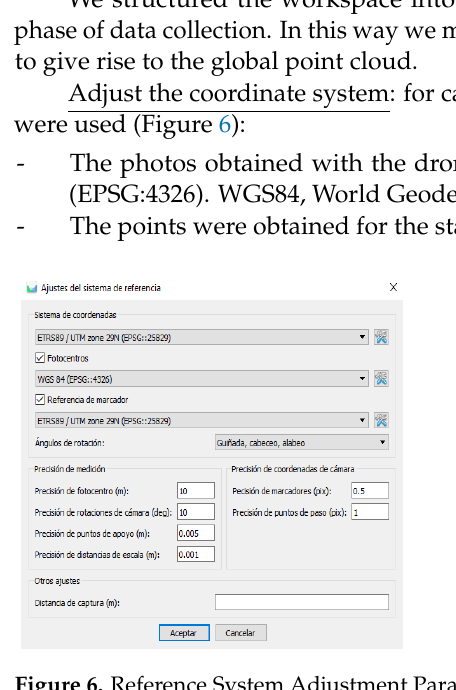
Figure 5. Workflow scheme for point cloud generation of heritage buildings.